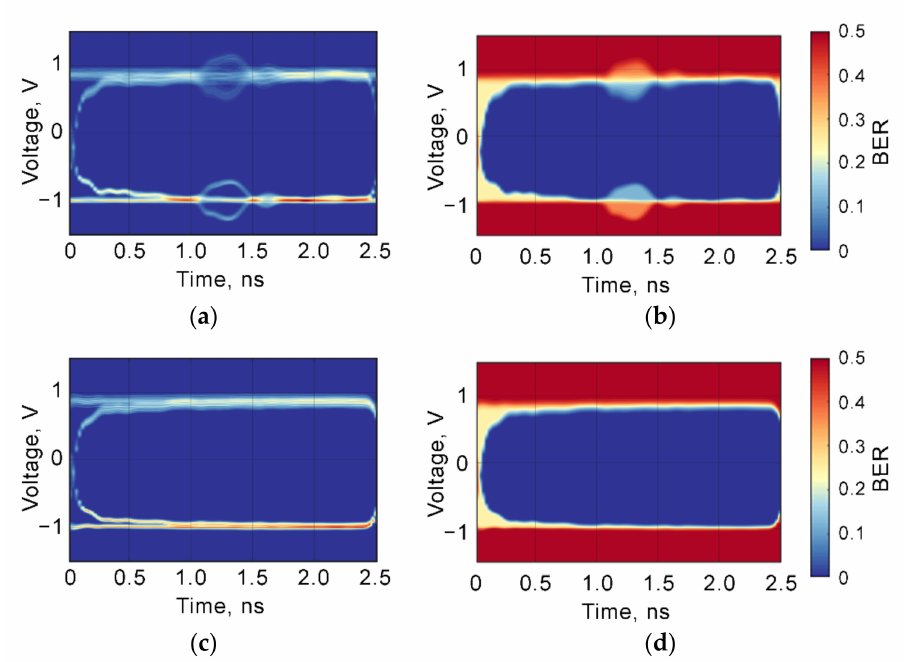
Figure 13. ( a ) Eye diagram of victim signal with crosstalk; ( b ) BER diagram of victim signal with crosstalk; ( c ) eye diagram of estimated signal; ( d ) BER diagram of estimated signal. Bit rate is 0.4 Gbit/s.